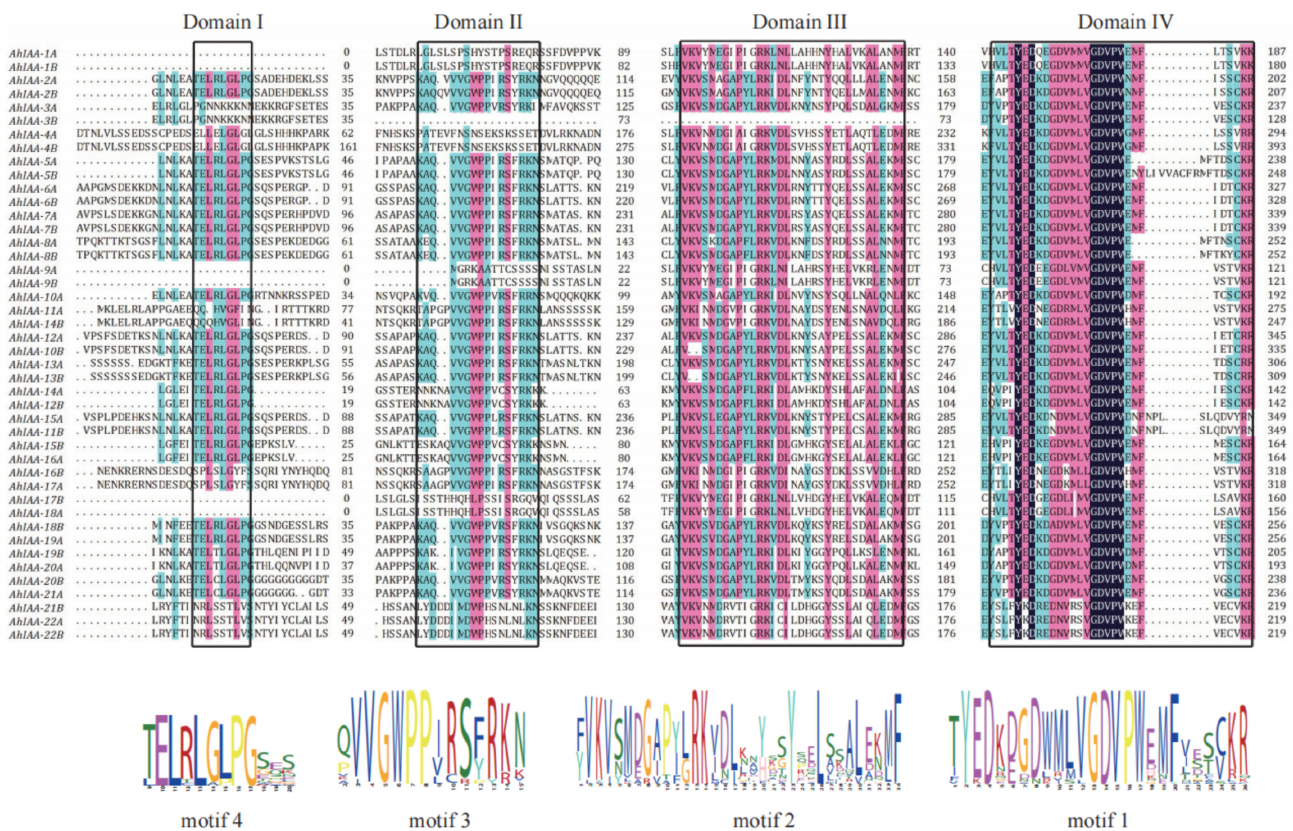
Figure 3. Conserved domains and detailed sequences information of their corresponding motifs detected in peanut AhIAA